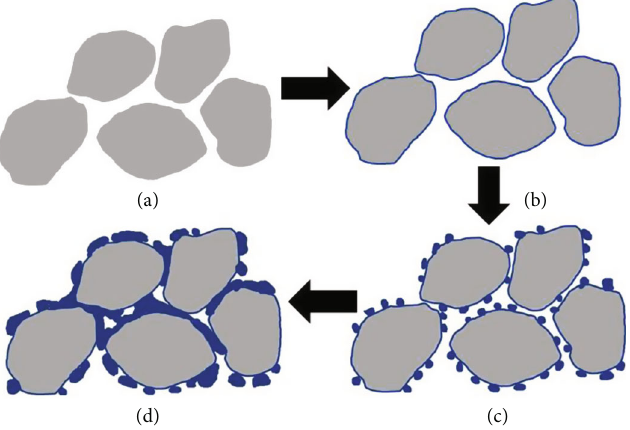
Figure 8: Schematic for the cumulative processes of calcium carbonate precipitation within the pore